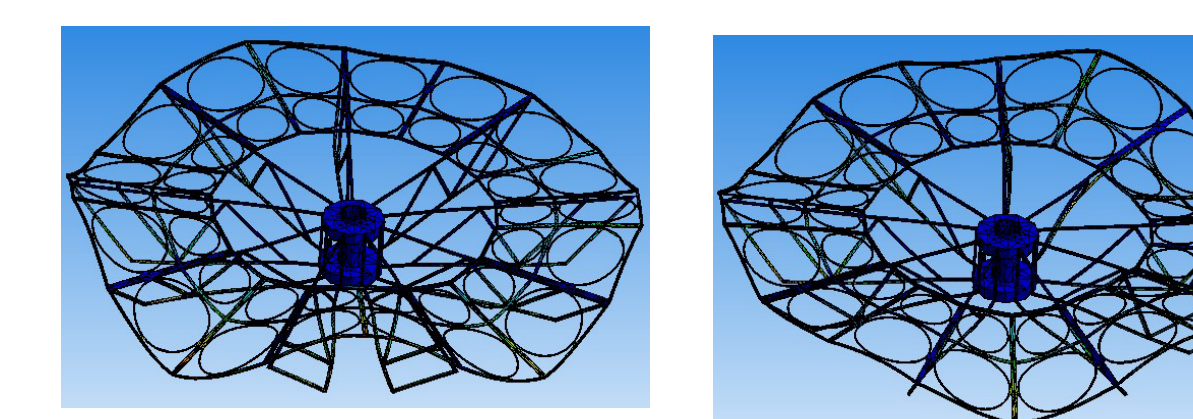
Figure 10. Third-order mode shape of free